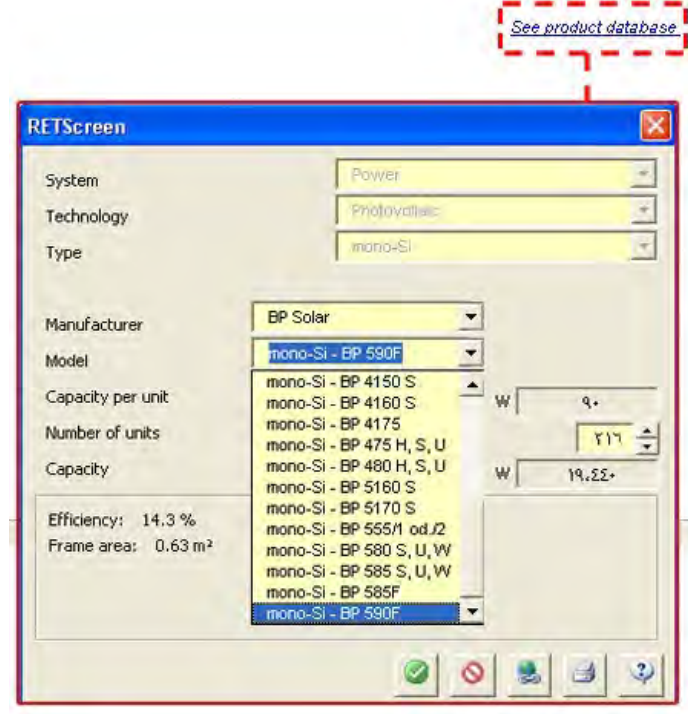
Figure 9. The panel data window which will be used (”Renewable Energy Technologies Screen”, n.d.)